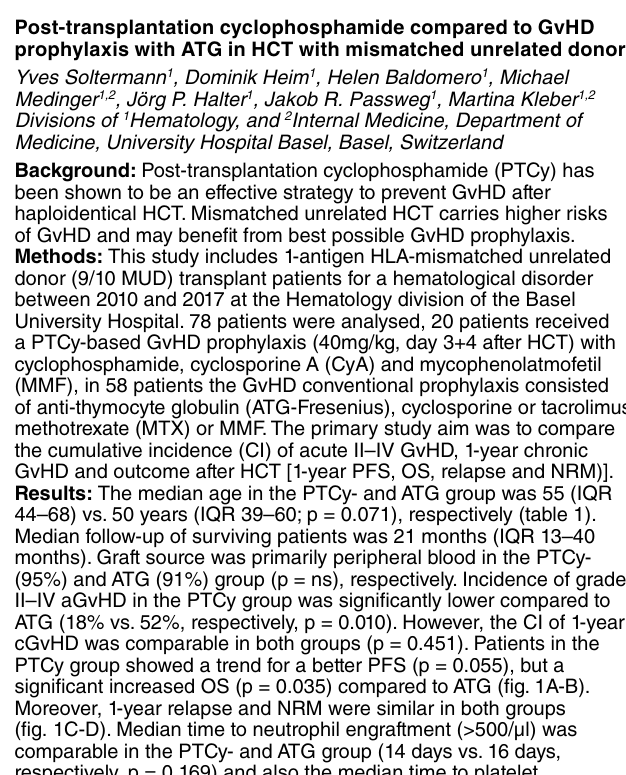
(fig. 1C-D). Median time to neutrophil engraftment (>500/µl) was comparable in the PTCy- and ATG group (14 days vs. 16 days, respectively, p = 0.169) and also the median time to